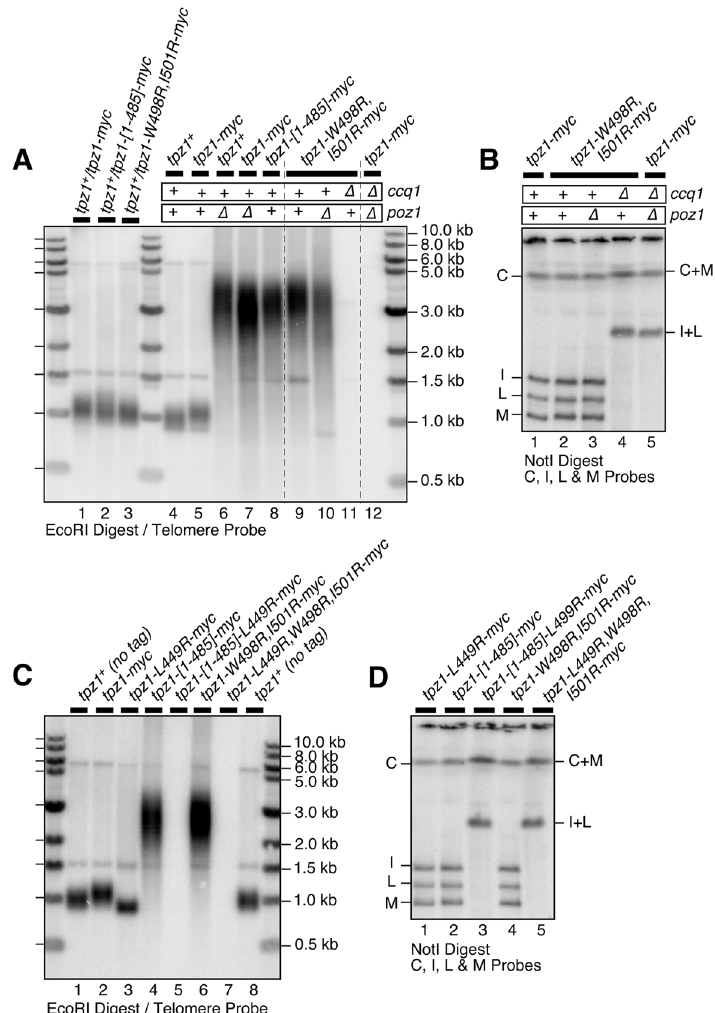
Figure 6. Effects of Tpz1-Poz1 interaction disruption mutations on telomere maintenance. ( A ) Southern blot analysis and ( B ) pulsed-field gel analysis for indicated Tpz1-Poz1 interaction disruption mutants. Haploid cells were generated by dissection of spores derived from heterozygous tpz1 + /mutated tpz1 diploid cells, and restreaked 5 times on plates prior to preparation of genomic DNA to achieve steady state telomere length, except for tpz1-W499R,I501R poz1 D and ccq1 D poz1 D cells where DNA from survivors with circular chromosomes were made after restreaked twice on plates. For each round of restreak, several faster growing colonies were combined and streaked for single colonies on YES plates. ( C ) Southern blot analysis and ( D ) pulsed-field gel analysis for mutants that disrupted either Tpz1-Ccq1 or Tpz1-Poz1 interaction, or both Tpz1-Ccq1 and Tpz1-Poz1 interactions. DNA samples were prepared after restreaked twice on plates. Simultaneous loss of Tpz1-Ccq1 and Tpz1-Poz1 interactions resulted in complete loss of telomeres and circularization of chromosomes, much like in ccq1 D poz1 D , tpz1-L449R poz1 D and tpz1-W498R,I501R ccq1 D